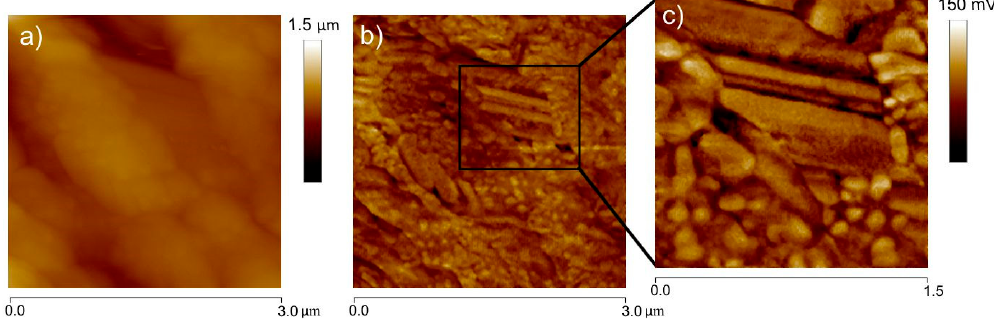
Figure 9. Morphological characteristics ( a ) tapping image and ( b ) deflection image of ZnO nanorod film on ITO (indium-tin-oxide) / PET (polyethylene terephthalate) substrate, ( c ) inset 1.5 µ m of deflection image.